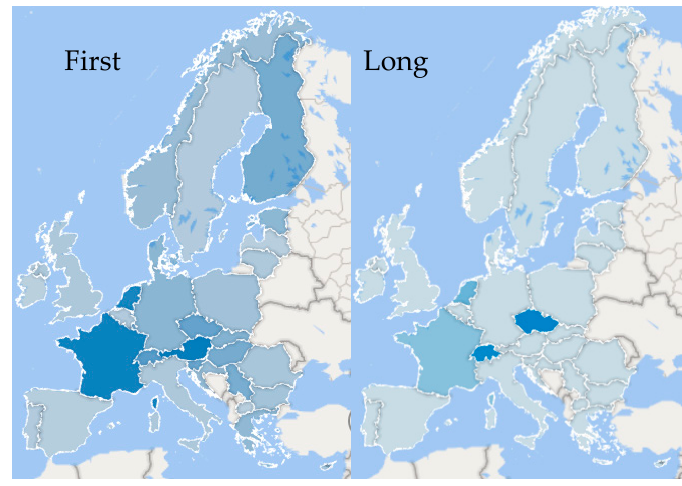
Figure 22. Number of precedence by country, first and long precedence group Soc.